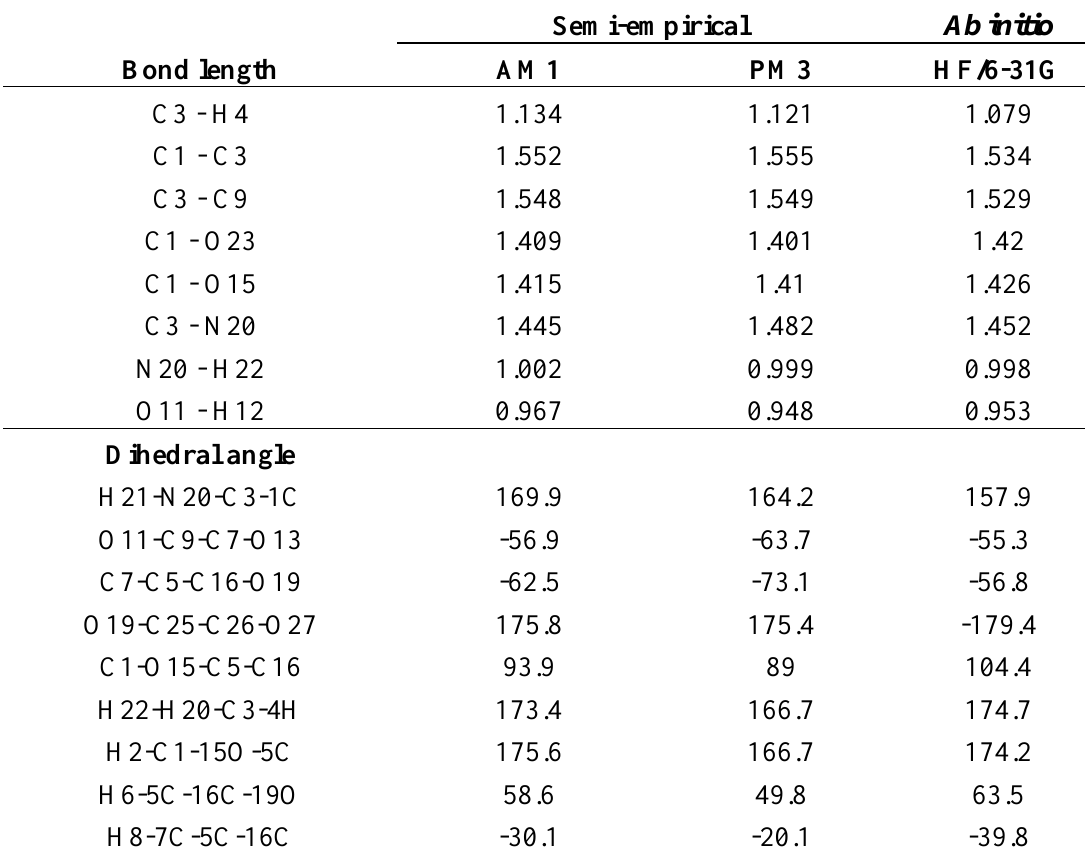
Table 2. Geometrical parameters of optimized glucosamine(ethylene glycol)